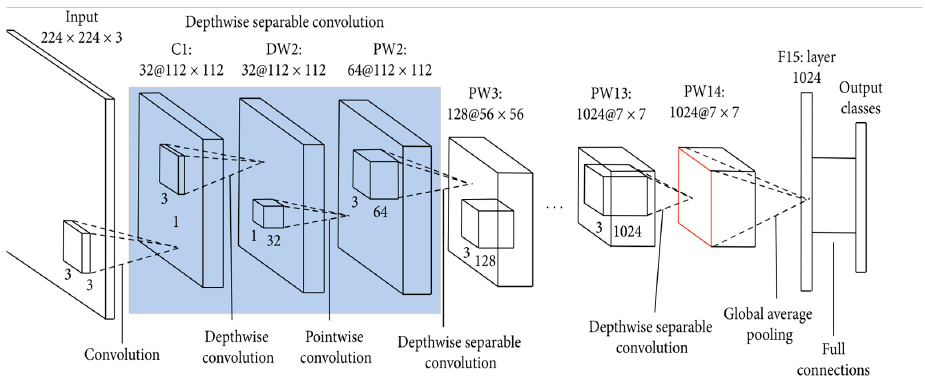
Figure 4. The MobileNet Architecture [43].